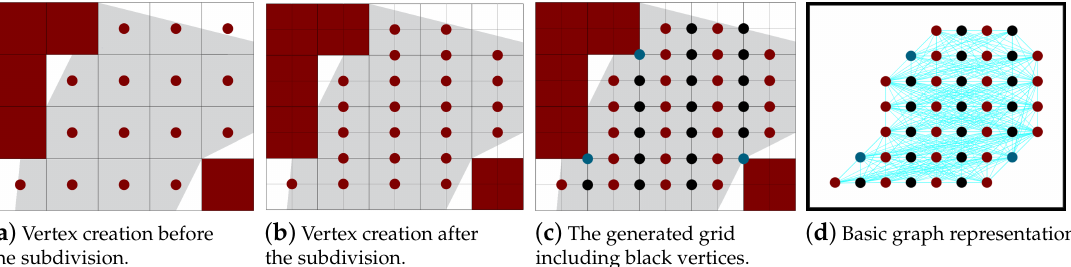
Figure 5. Vertex creation (before and after the sub-division) and the basic graph representation of the